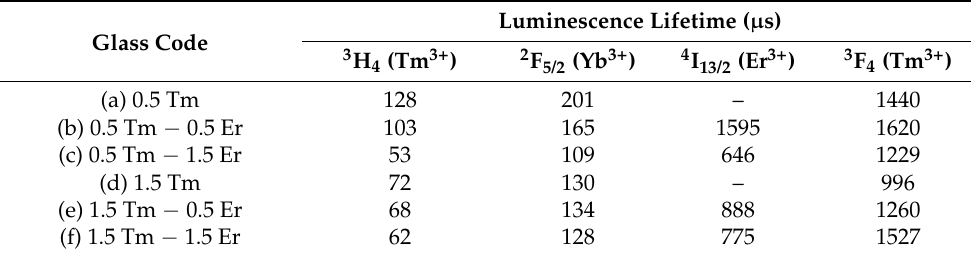
Table 1. Luminescence lifetimes for the excited states of lanthanide ions in lead germanate glass calculated based on decay curve